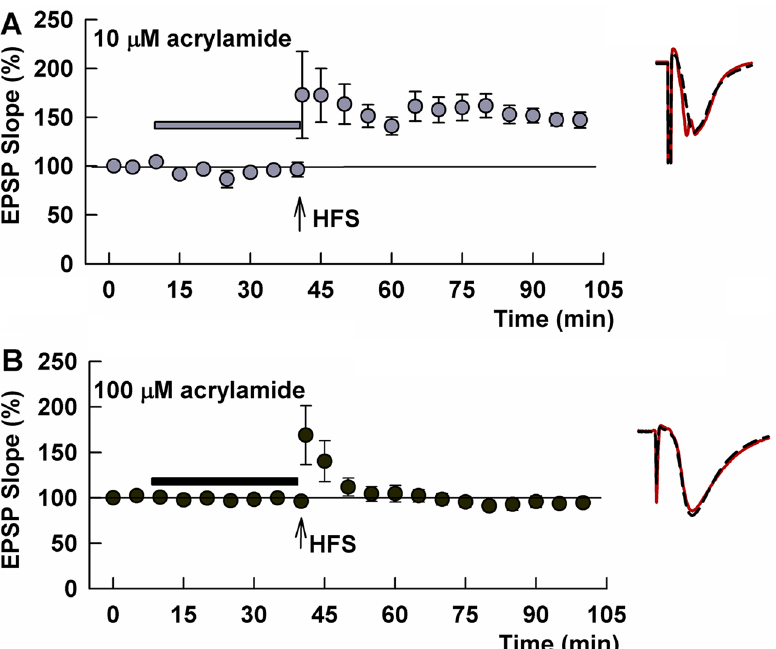
Figure 3. ACR acutely inhibits LTP in the CA1 region of rat hippocampal slices. ( A ) When administered for 30 min, 10 µM ACR (gray bar) does not inhibit the induction of LTP in response to HFS (arrow) (gray circles). ( B ) 100 µM ACR (black bar) acutely inhibits LTP (black bar). Traces to the right of these graphs show representative EPSPs at baseline before HFS (dashed traces) and 60 min following HFS (solid red lines). Calibration bar (Panel B): 1 mV, 5